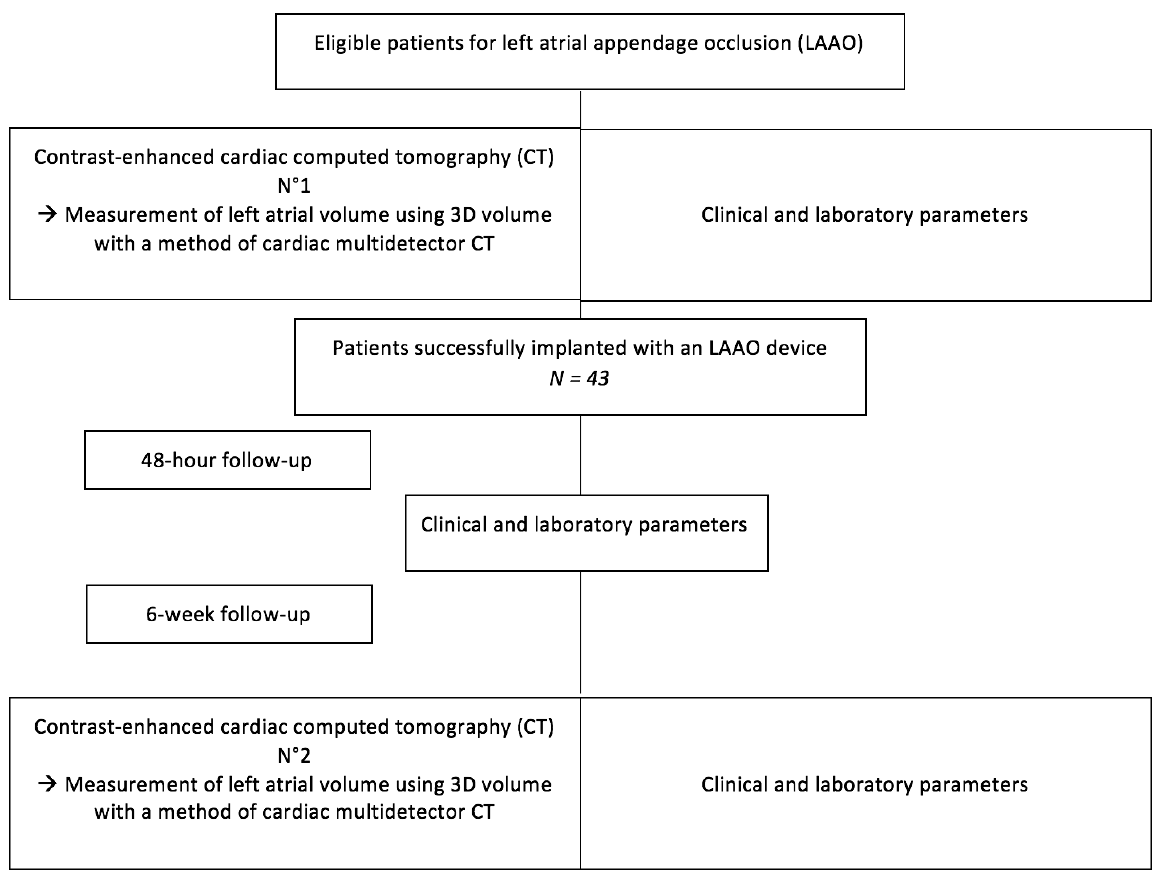
Figure 1. Flow chart of the study.